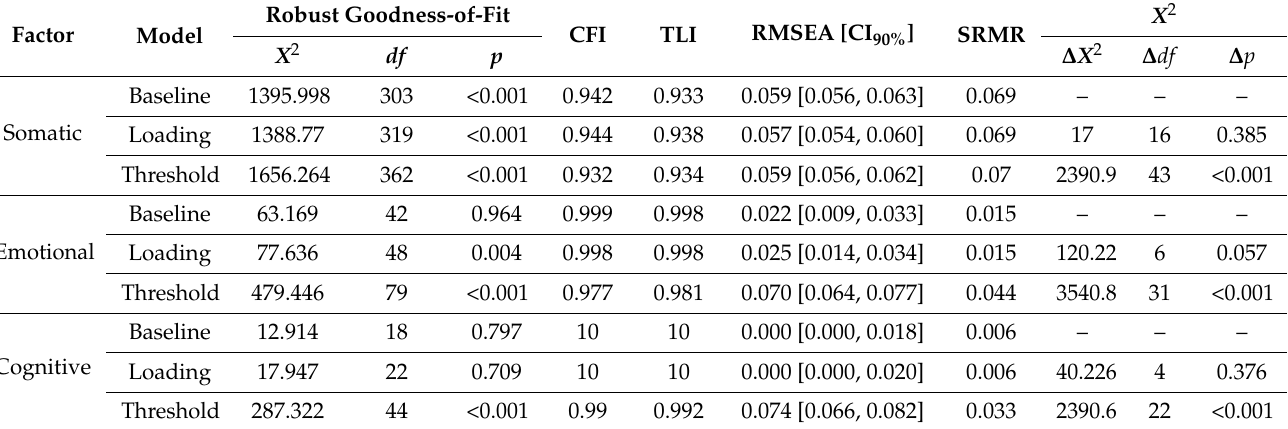
Table 3. Results from the longitudinal measurement invariance tests for the factors using the